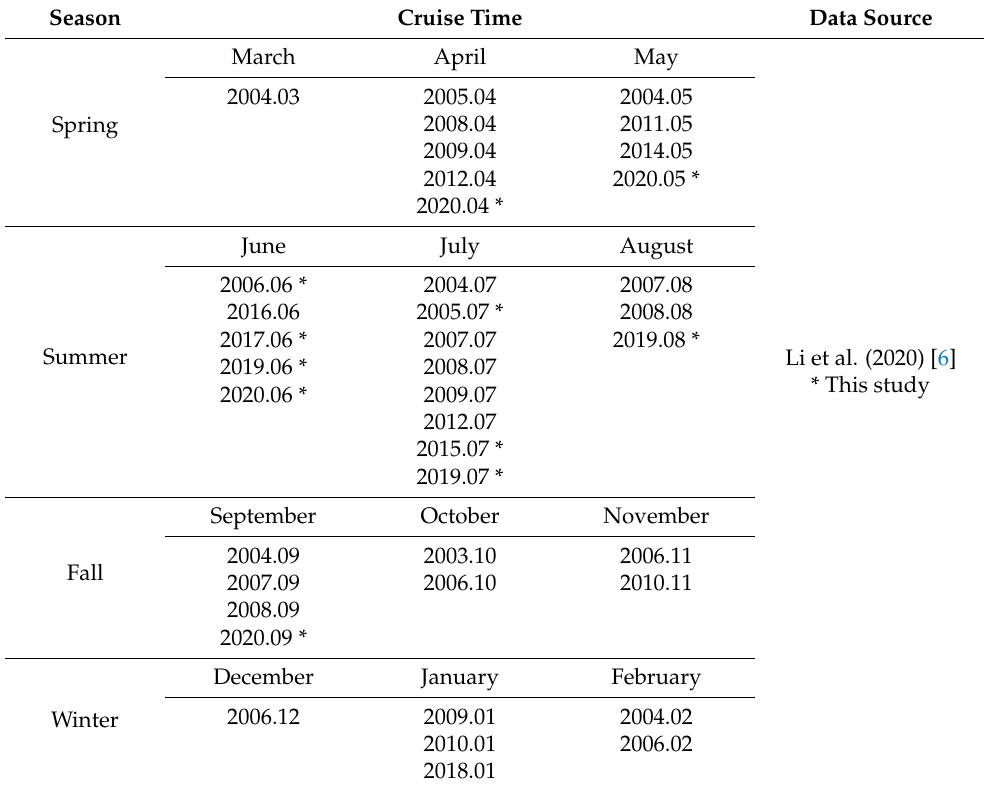
Table 1. Seasonal underway sea surface salinity (SSS) data in the South China Sea compiled in this